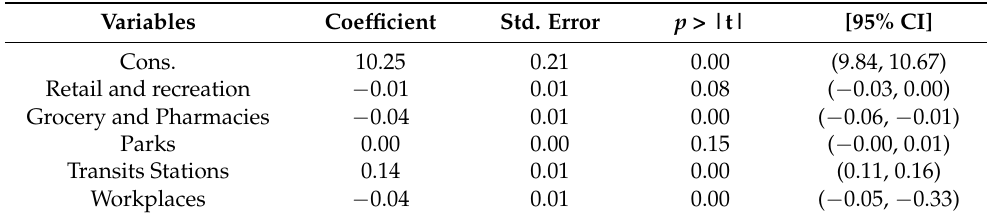
Table 2. Multiple linear regression analysis of the mobility categories and new COVID-19 daily confirmed cases.